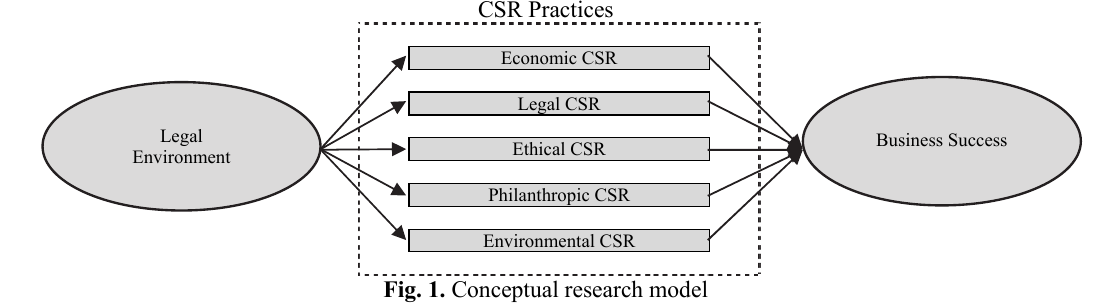
Fig. 1. Conceptual research